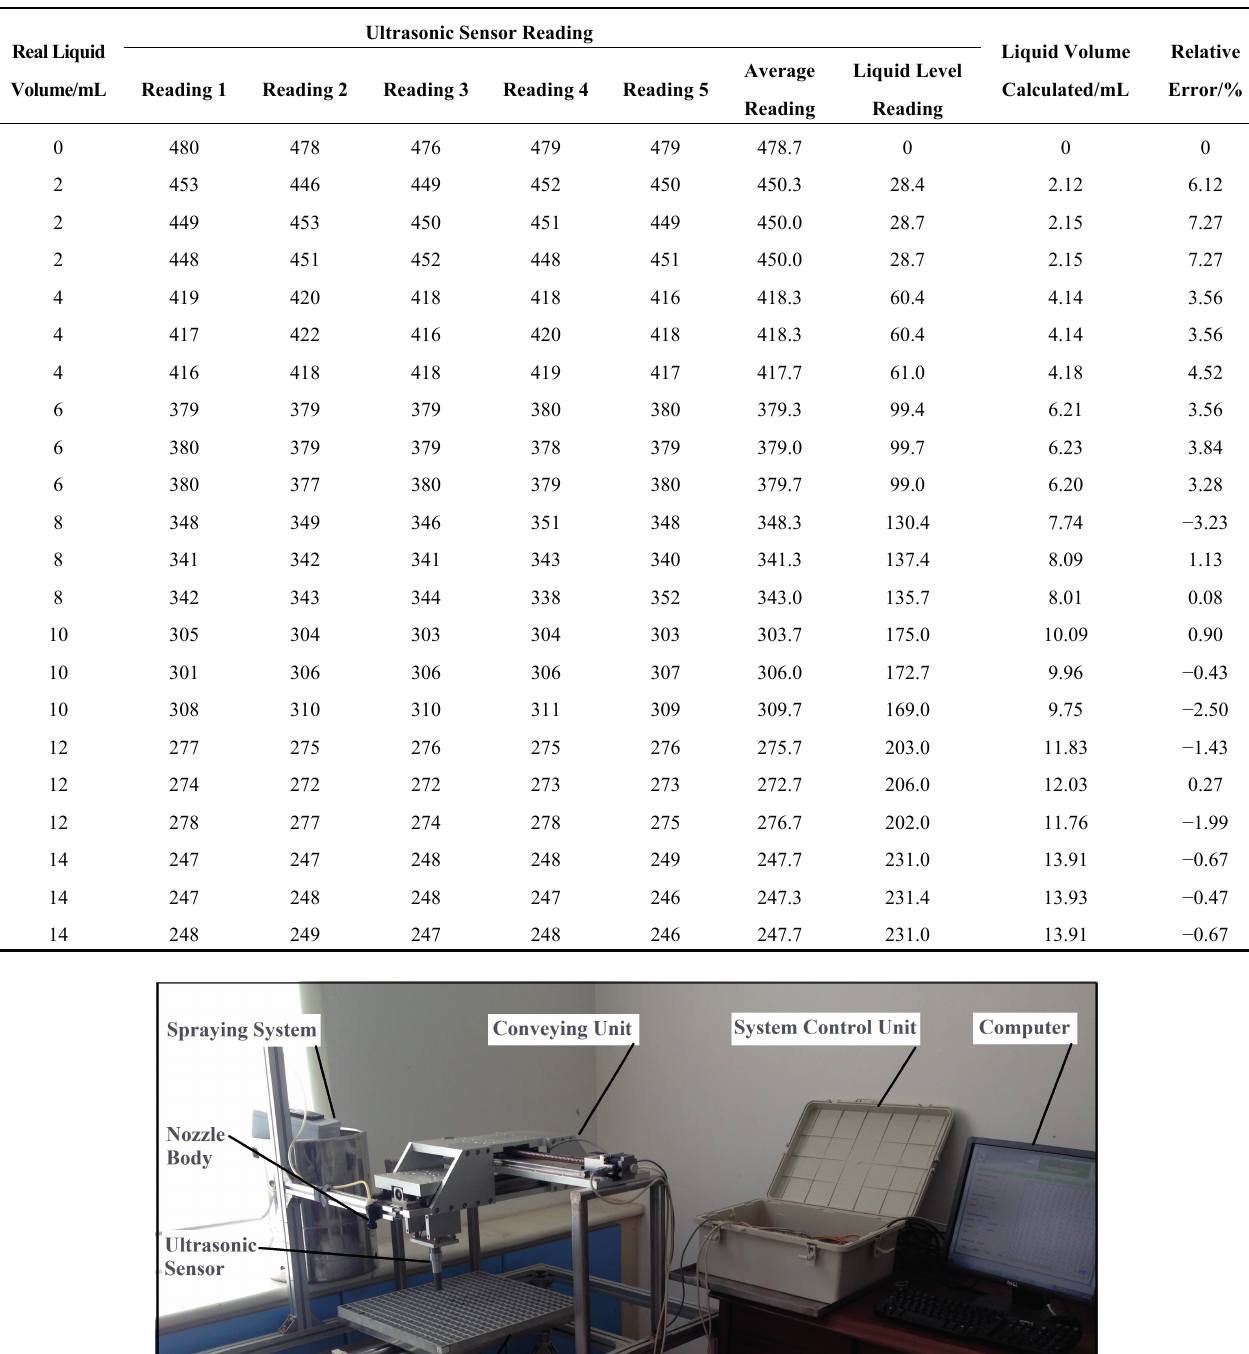
Table 3. Precision test of the two-dimensional automatic measuring system.